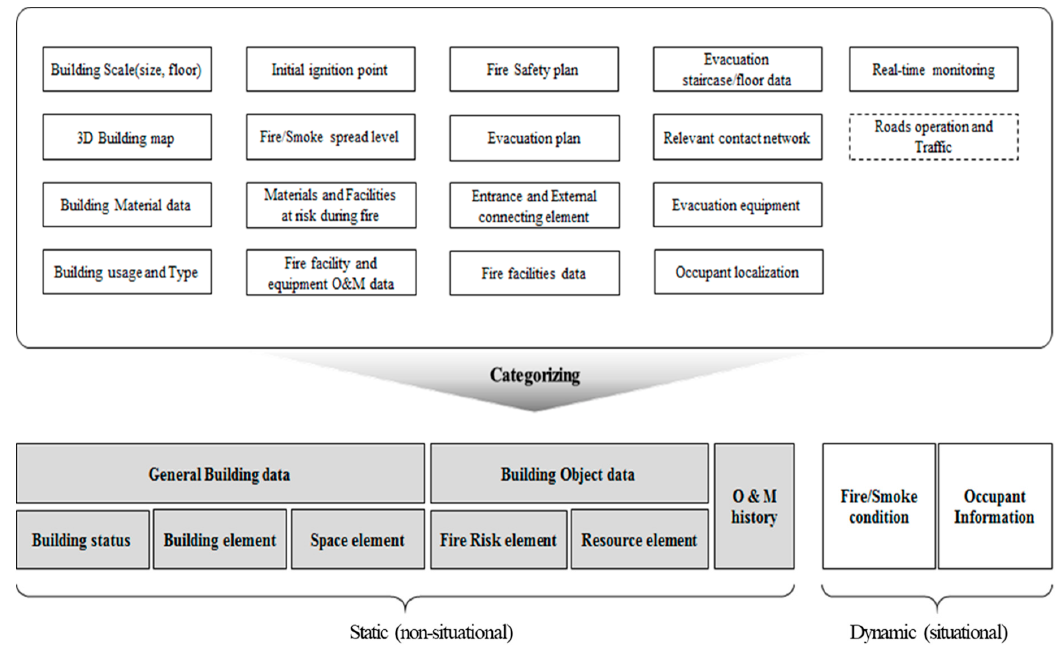
Figure 1. Categorization of the data structure based on the literature review . Table 1. Static (non-situational) information breakdown structure for Building Fire Information